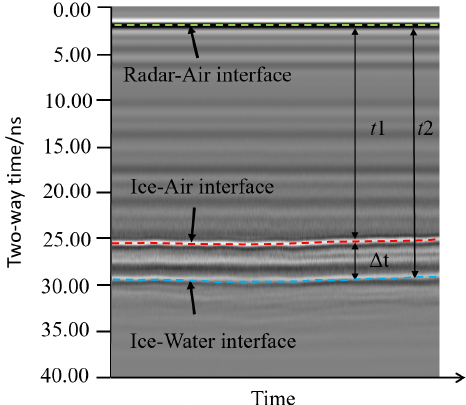
Figure 3. A typical GPR profile (one